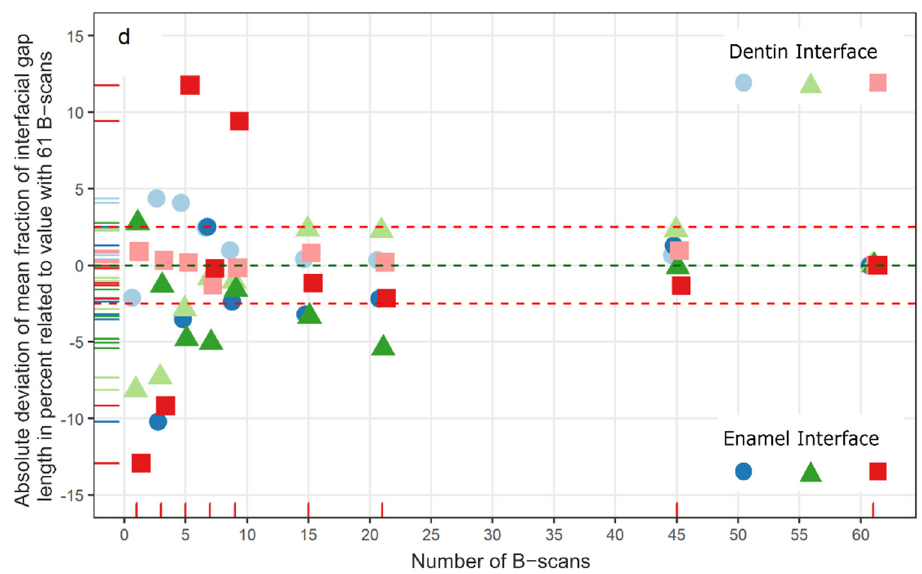
Figure 2. Scatter plots for teeth 13 ( a ), 24 ( b ), 45 ( c ), and for all teeth ( d ). The plots show the absolute deviation of the weighted mean fraction of the interfacial gap length (enamel and dentin) from the value using 61 cross-sectional images as a function of the number of B-scans (N: 1, 3, 5, 7, 9, 15, 21, 45, and 61). The red dashed lines indicate the (statistical) range of ±2.5% of the deviation of means, compared to 61 B-scans. Depending on the restoration examined, their deviation was up to ±13%, with less than 15 B-scans.